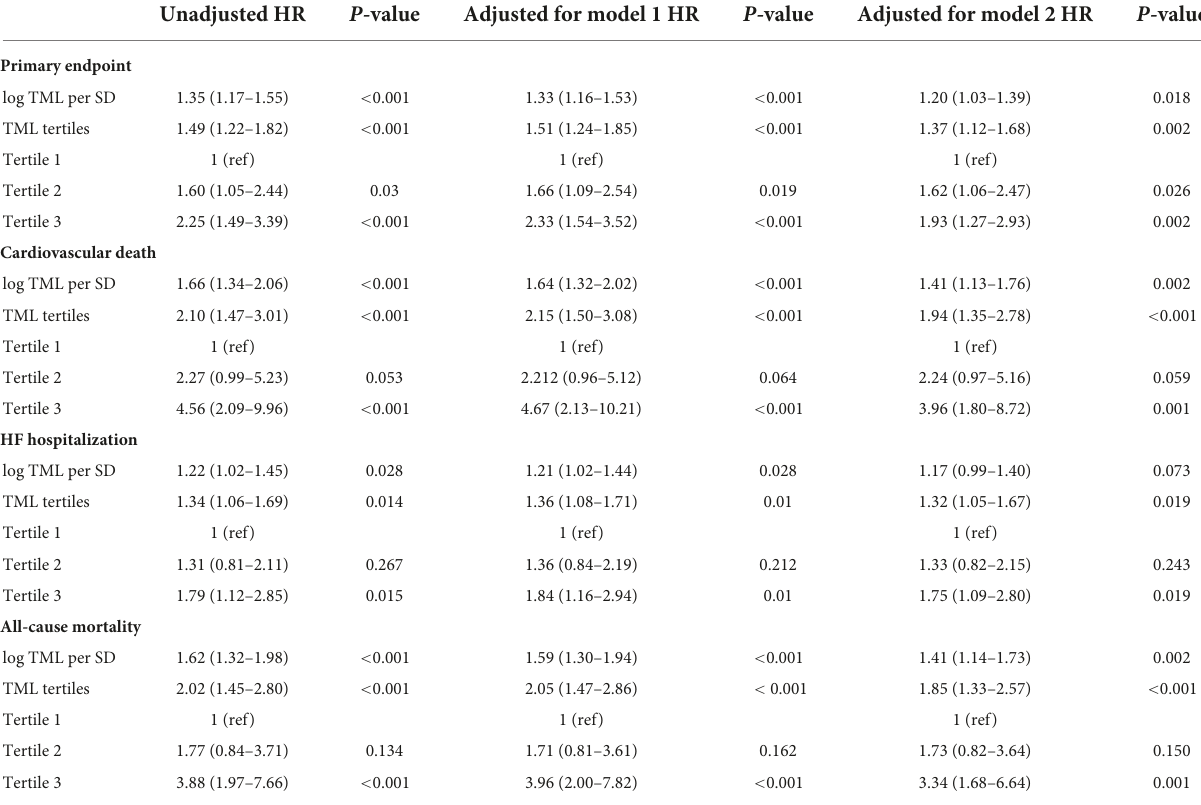
TABLE 3 Trimethyllysine (TML) was associated with poor prognosis in patients with heart failure (HF).